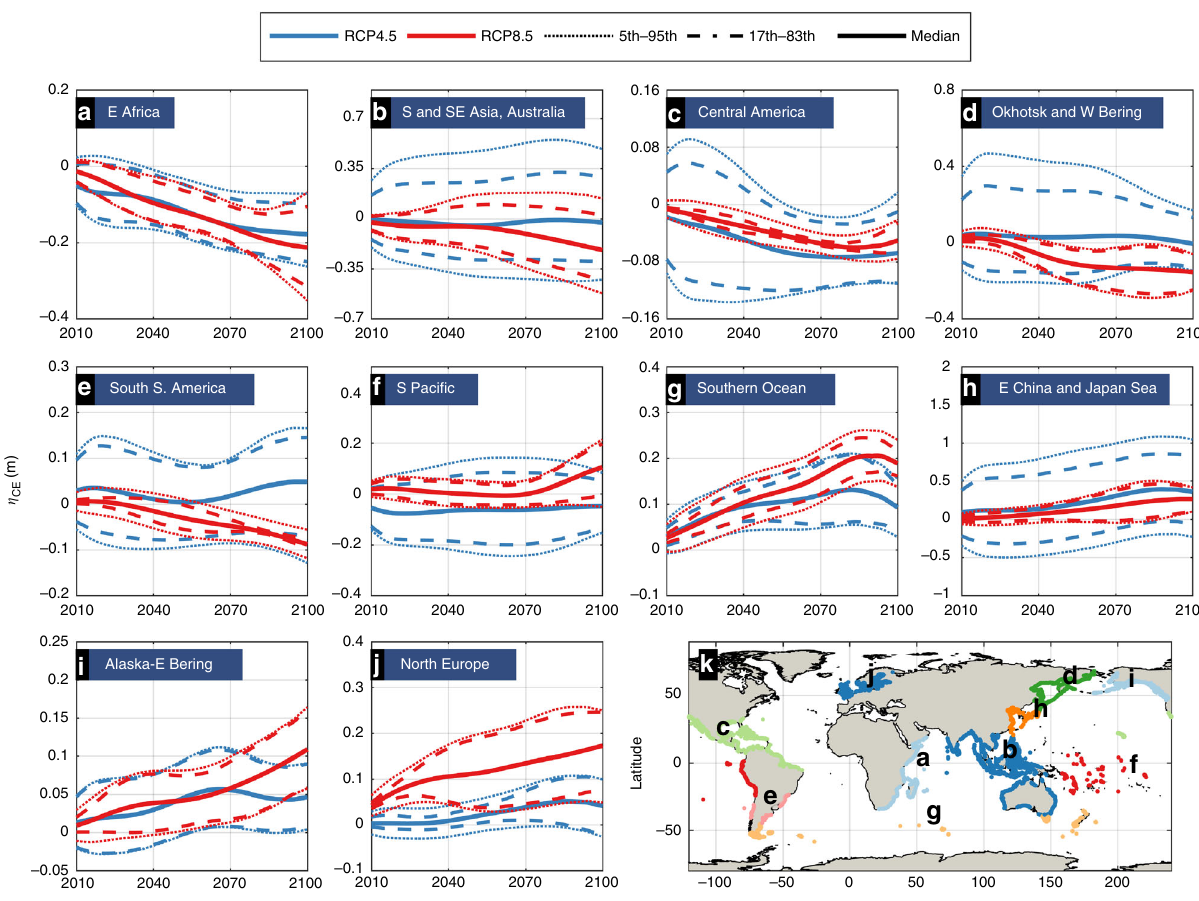
Fig. 4 Regional projected changes in the contributions of climate extremes (wind-waves and storm surges) to global ESLs ( η CE ). Time series of the projected change in 100-year η CE under RCP4.5 (blue) and RCP8.5 (red). The geographical regions are highlighted in k . Heavy: median, dotted: 5 – 95th percentiles (very likely) and dashed: 17 – 83th percentiles